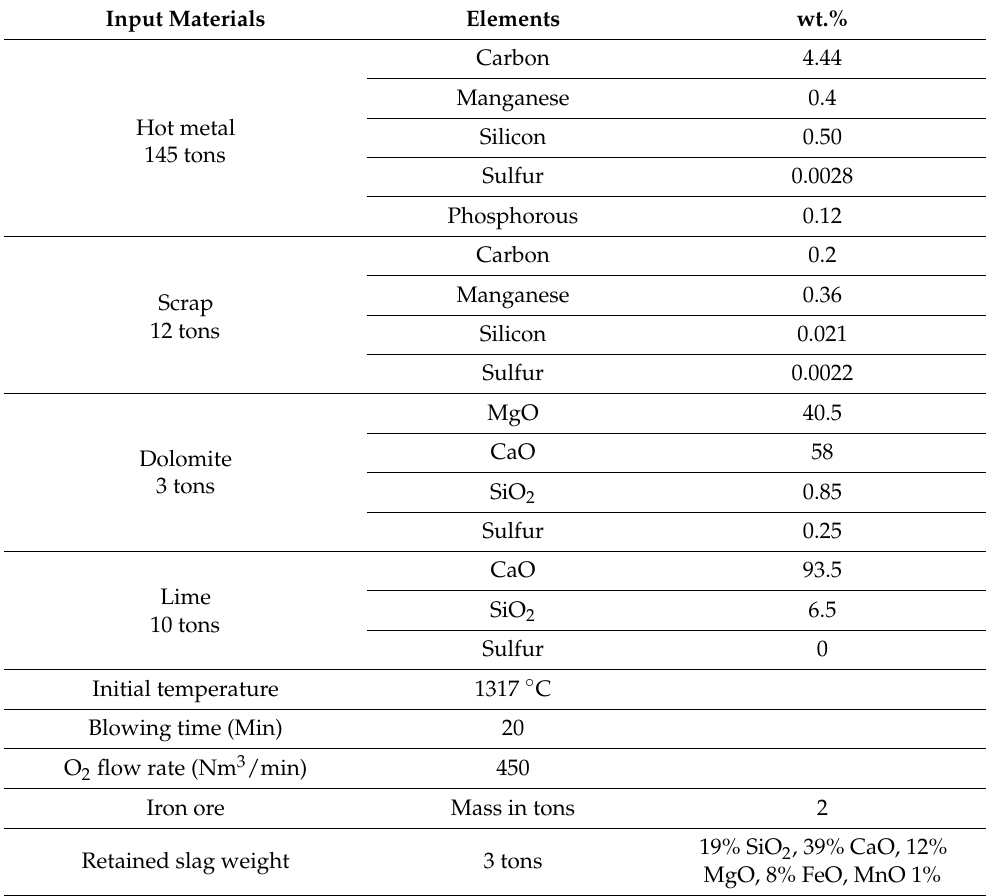
Table 1. Input details of thermodynamic modelling of basic oxygen steel-making